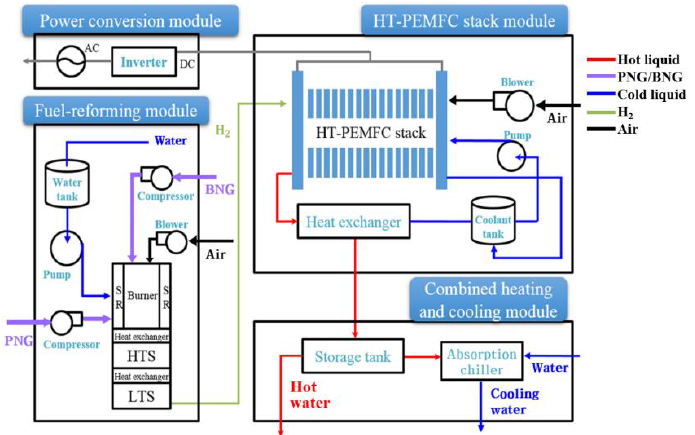
Figure 1. Configuration of a high temperature-proton exchange membrane fuel cells (HT-PEMFC) system with tri-generation.